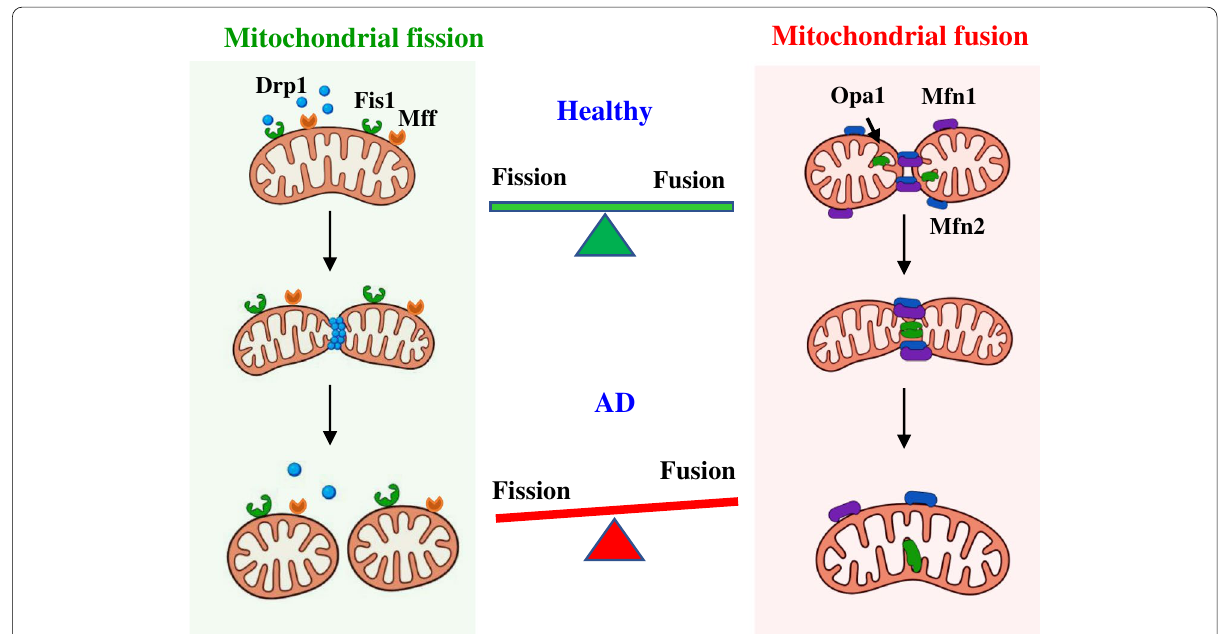
Fig. 3 Mitochondrial fission and fusion. Under healthy conditions, the healthy mitochondrial network is maintained by the balance of mitochondria fission (right) and fusion. Drp1 is located in the cytosol, and Fis1 and Mff are located on the outer mitochondrial membrane. Mitochondrial fission occurs when the Fis1 and MFF recruit cytosolic Drp1 to the outer mitochondrial membrane. Mitochondrial fusion is mediated by Mfn1 and Mfn2 from the mitochondrial outer membranes and Opa1 in the mitochondrial inner